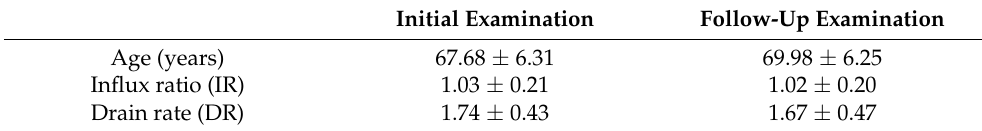
Table 1. Follow-up study